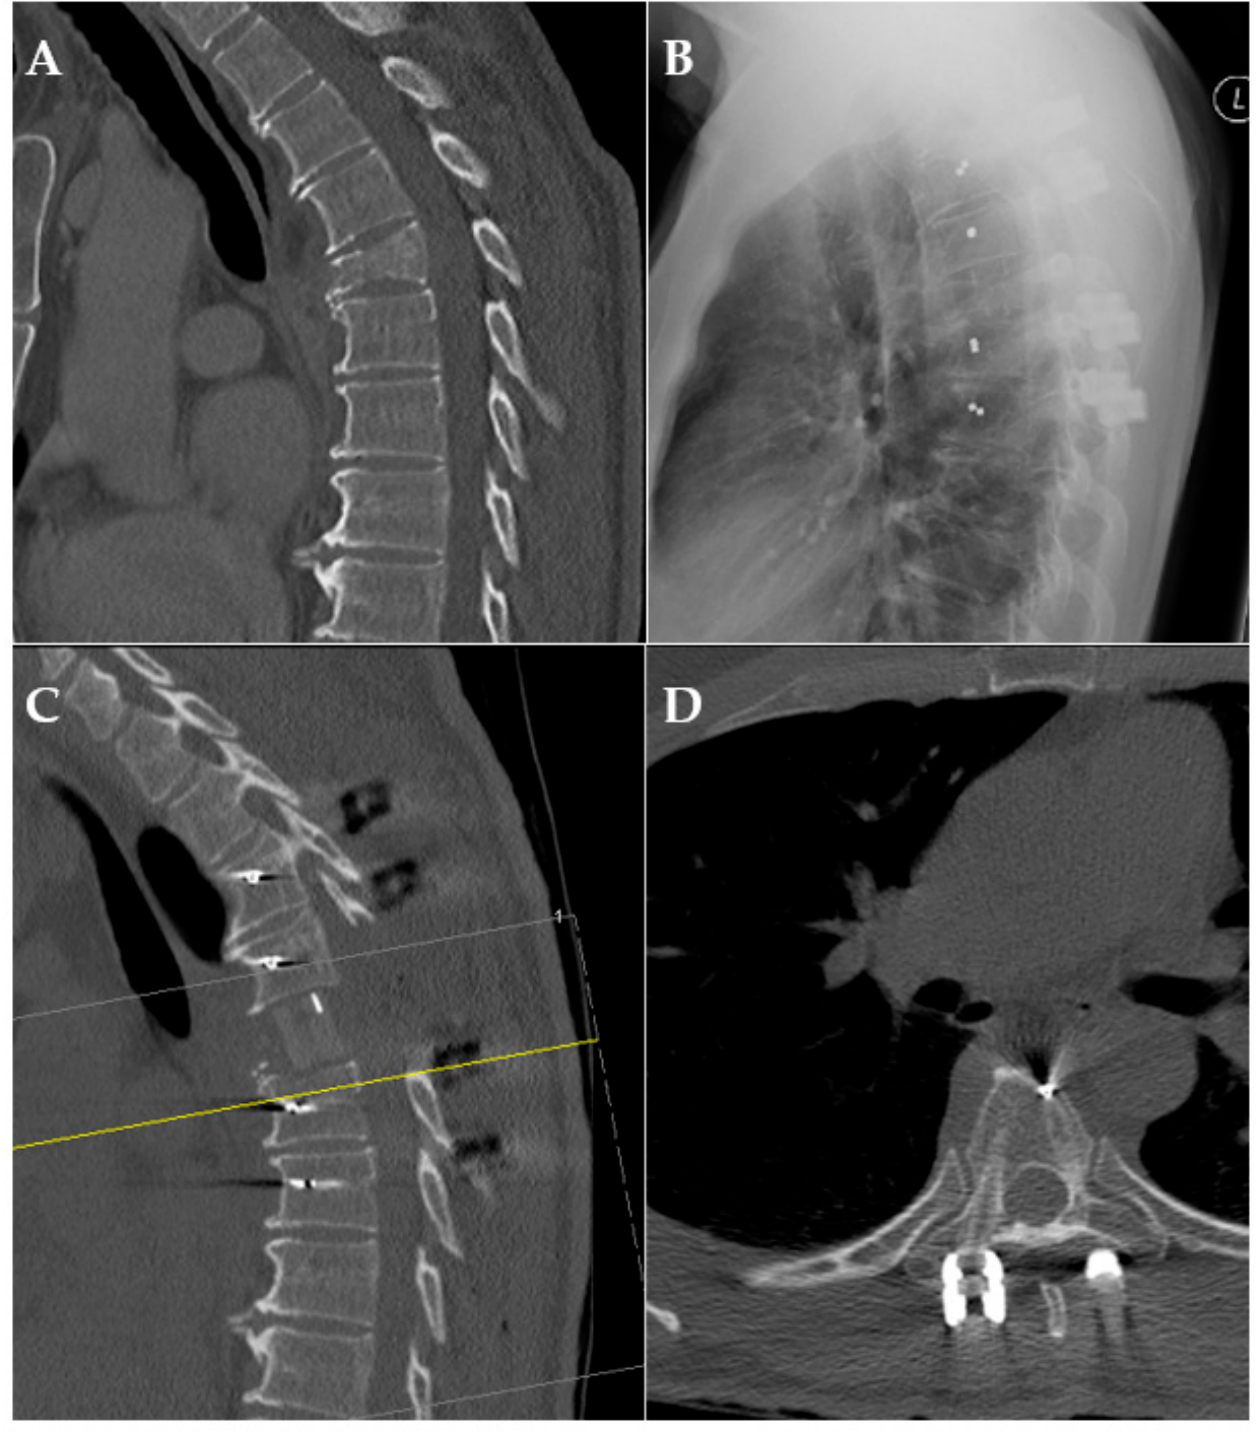
Figure 4. Exemplary case of pre-/postoperative CT scan and X-ray. ( A ): preoperative CT scan of a pathological fracture of the thoracic spine; ( B ): X-ray after posterior fusion; ( C , D ): CT scan after posterior fusion and anterior reconstruction demonstrating radiolucency. Table 3. Surgical details: MIS = minimally invasive surgery, n = number, n /a = not available, SD = standard deviation, w/o = without.